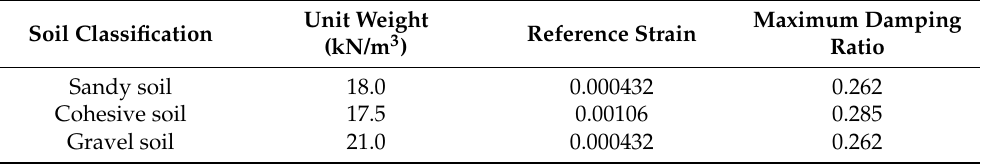
Table 1. Parameters of subsurface soil models by the soil